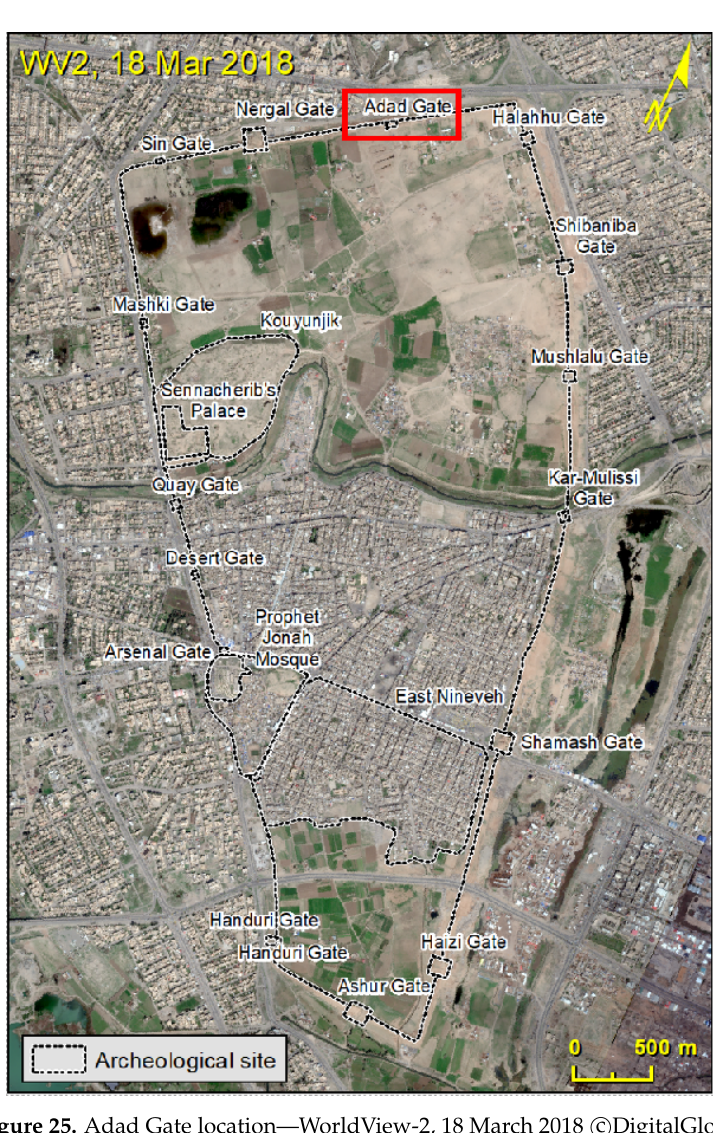
Figure 25. Adad Gate location—WorldView-2, 18 March 2018 c (cid:13) DigitalGlobe.